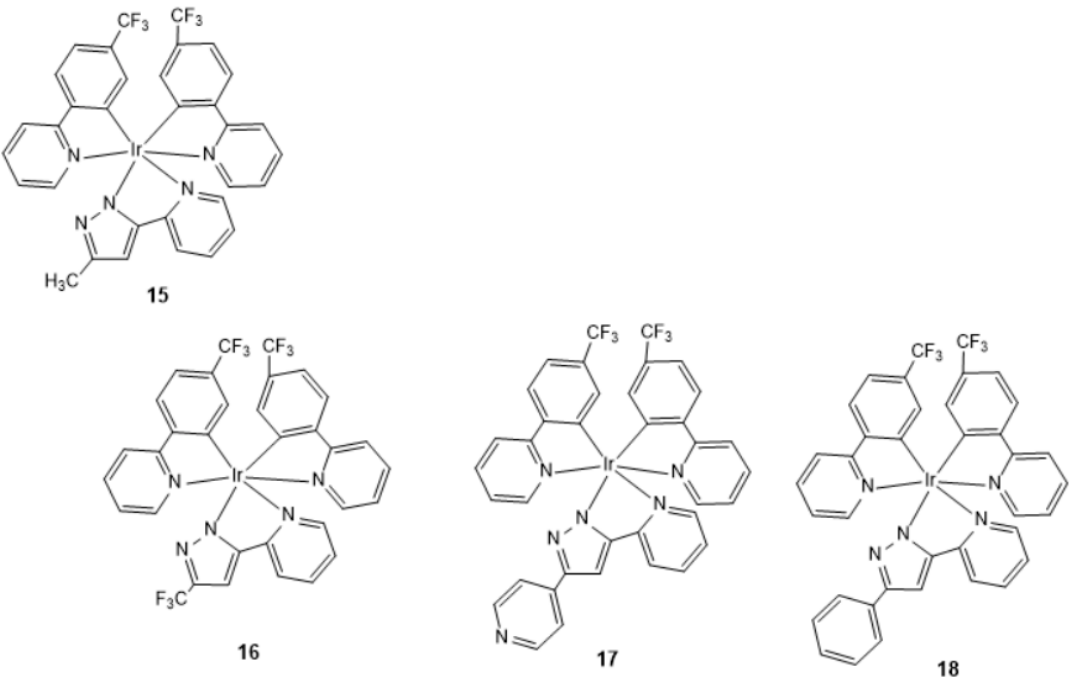
Scheme 4. Structures of pyrazole containing cyclometalated Ir(III) complexes